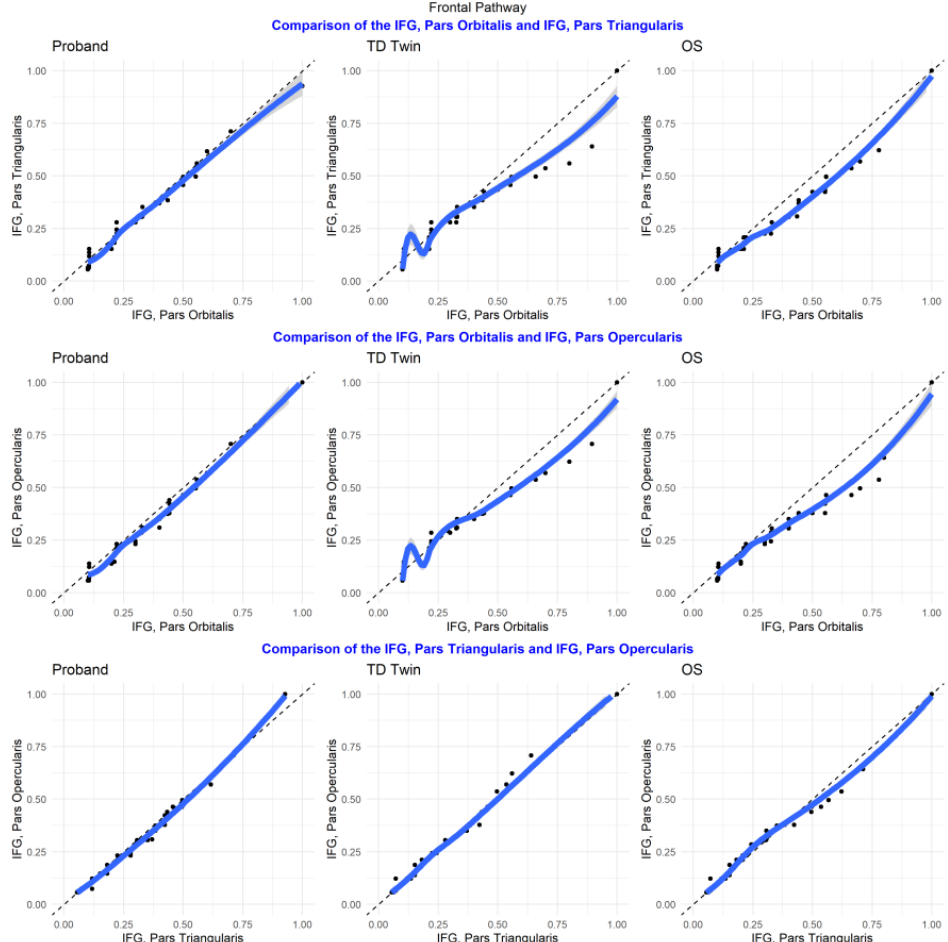
Figure 11. Q–Q plots of region of interest comparisons for regions in the frontal Figure 11. Q – Q plots of region of interest comparisons for regions in the frontal pathway.